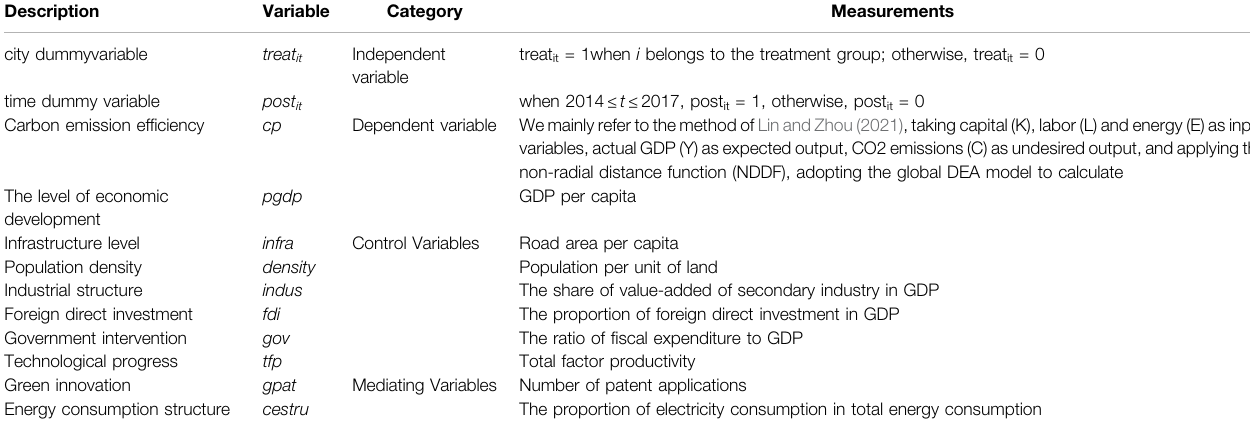
TABLE 1 | Variable de fi nitions.